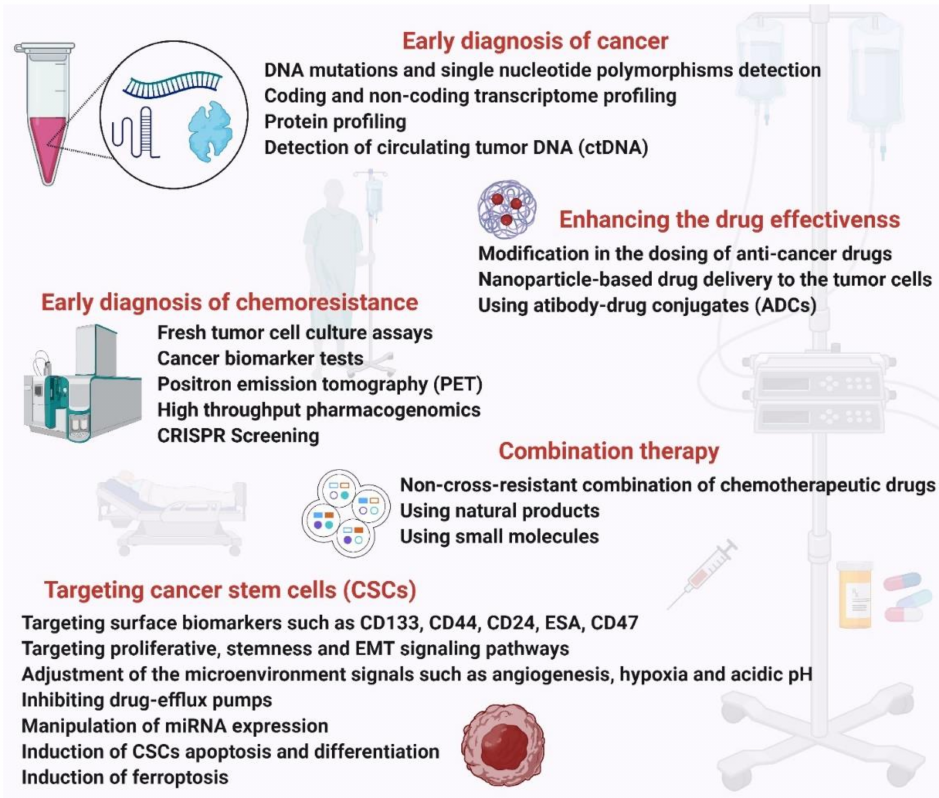
Figure 5. The strategies to combat chemoresistance in human